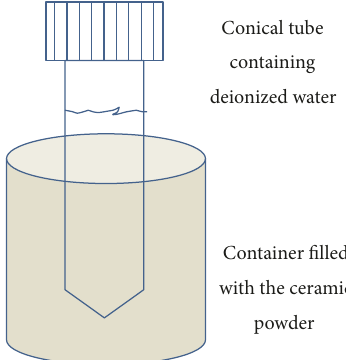
Figure 2: Preparation of water in the noncontact method . Deionized waterina50 mlvialwasputupintotheceramicpowderfortwodays and used for the preparation of culturing media by mixing with the powder form